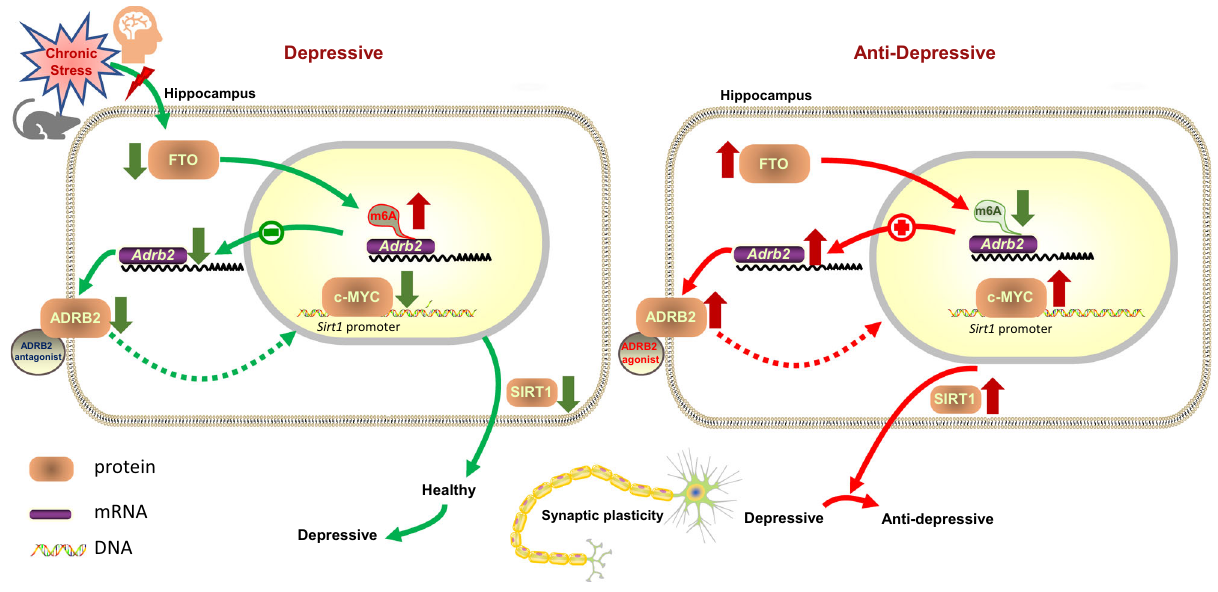
Fig. 7 Schematic illustration summarizing the current work. FTO expression is downregulated in the hippocampus of both patients with major depressive disorder (MDD) and chronic stress-induced mouse models of depression. Downregulation of FTO leads to elevated m 6 A modi fi cation level of Adrb2 mRNA, which results in lower mRNA and protein expression of Adrb2 ; in contrast, enhancing FTO expression in the hippocampus reduces the m 6 A modi fi cation level of Adrb2 mRNA, which results in higher expression levels of Adrb2 mRNA and protein. The activation of ADRB2 can increase the expression of c-MYC, while pretreatment with an ADRB2 antagonist blocks the effects. In vitro, c-MYC can bind to the Sirt1 promoter. The activation of ADRB2 also increases the expression of SIRT1, while pretreatment with the antagonist blocks the effects. However, how the signal is transduced from ADRB2 to c-MYC has yet to be clari fi ed. ADRB2 activation reverses the depression-like behaviors and spine loss induced by FTO de fi ciency in the hippocampus. Overexpression of SIRT1 in the hippocampus also reverses the depression-like behaviors in Fto cKO mice. The picture material was downloaded from ScienceSlides Cell culture . The Neuro-2a cell line, provided by the Cell Resource Center (IBMS, CAMS/PUMC), was cultured in DMEM supplemented with 10% heat-inactivated fetal bovine serum (04-001-1 A, Biological Industries), 100U/mL penicillin, and 100 μ g/mL streptomycin at 37°C in 5% CO 2 . Plasmids were transfected into Neuro-2a cells using Neofect ™ DNA transfection reagent (TF201201, China). siRNA targeting Ythdf2 (sc-155424, Santa Cruz) was transfected into Neuro-2a cells using RNAi MAX (13778150, Thermo).